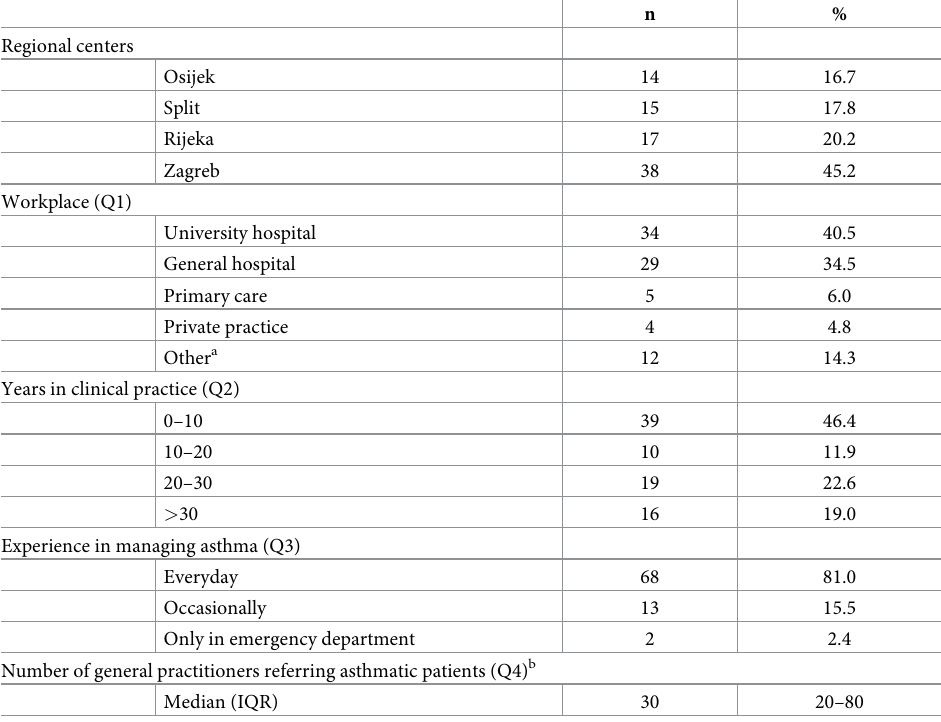
Table 1. Regional distribution of surveyed pulmonologists (N = 84) and their clinical